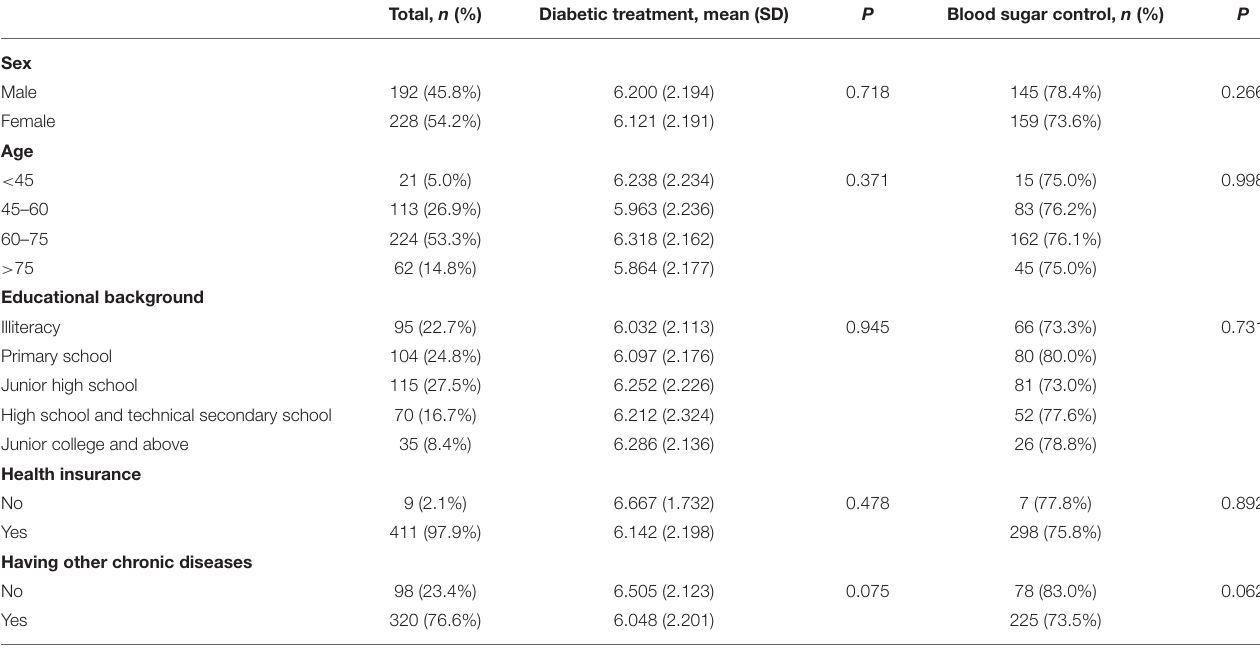
TABLE 2 | Characteristics of diabetic patients.